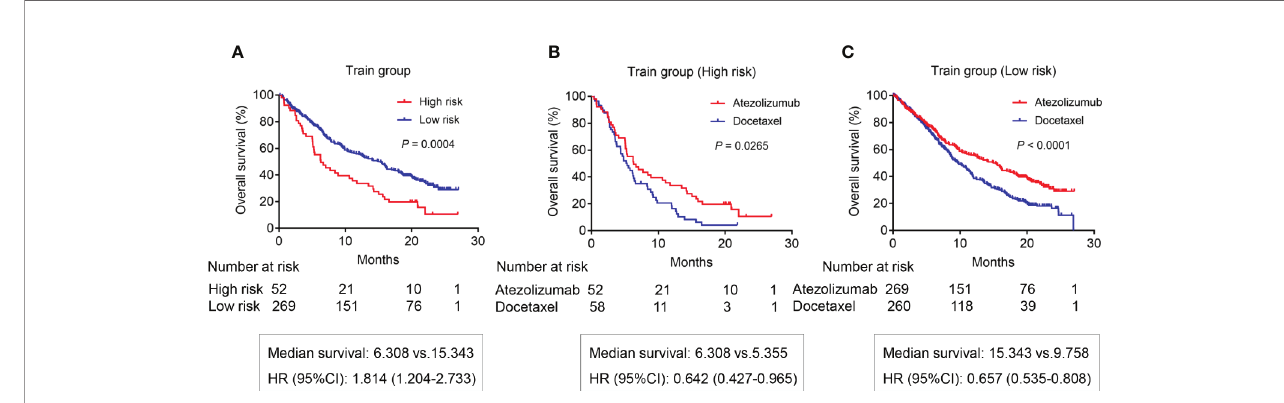
FIGURE 4 | The OS analysis for patients in the training group from OAK study. (A) The OS difference between the high risk and low risk patients receiving atezolizumab ( P = 0.0004). (B) The OS difference of high-risk patients between atezolizumab and docetaxel ( P = 0.0265). (C) The OS difference of low-risk patients between atezolizumab and docetaxel ( P